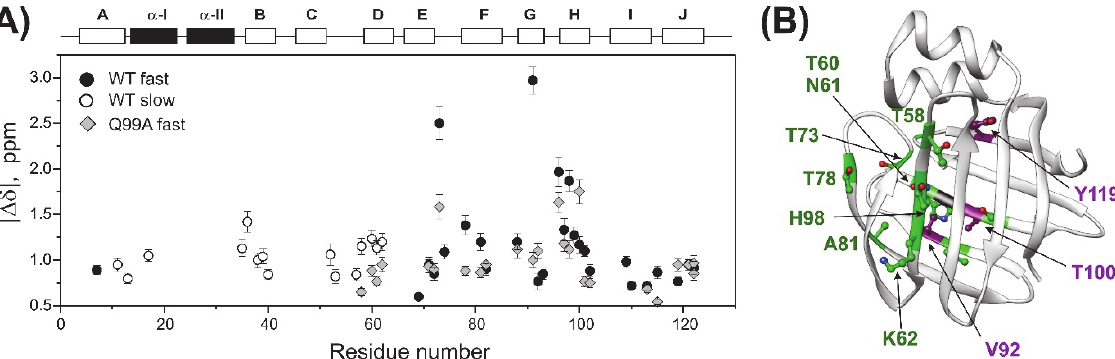
Figure 7. Backbone 15 N chemical shift differences between the ground and higher energy states. ( A ) Values of | ∆ δ | along the amino acid sequence as derived from CPMG relaxation dispersion measurements on wild-type (circle) and Q99A (quadrangle) apo human I-BABP with parameters listed in Table 2. For residues involved in global fluctuation at faster (cluster I) and slower (cluster II) exchange rates, values of | ∆ δ | are depicted in closed and empty symbols, respectively. Secondary structure elements are shown at the top. ( B ) Residues exhibiting a decrease (green) or increase (purple) in | ∆ δ | exceeding 20% in the mutant relative to the wild-type form are highlighted on the ribbon diagram of apo human I-BABP (PDB: 1O1U [15]). The position of the mutation is indicated in black.